Question: Based on the figure, does the quantity rise or fall?
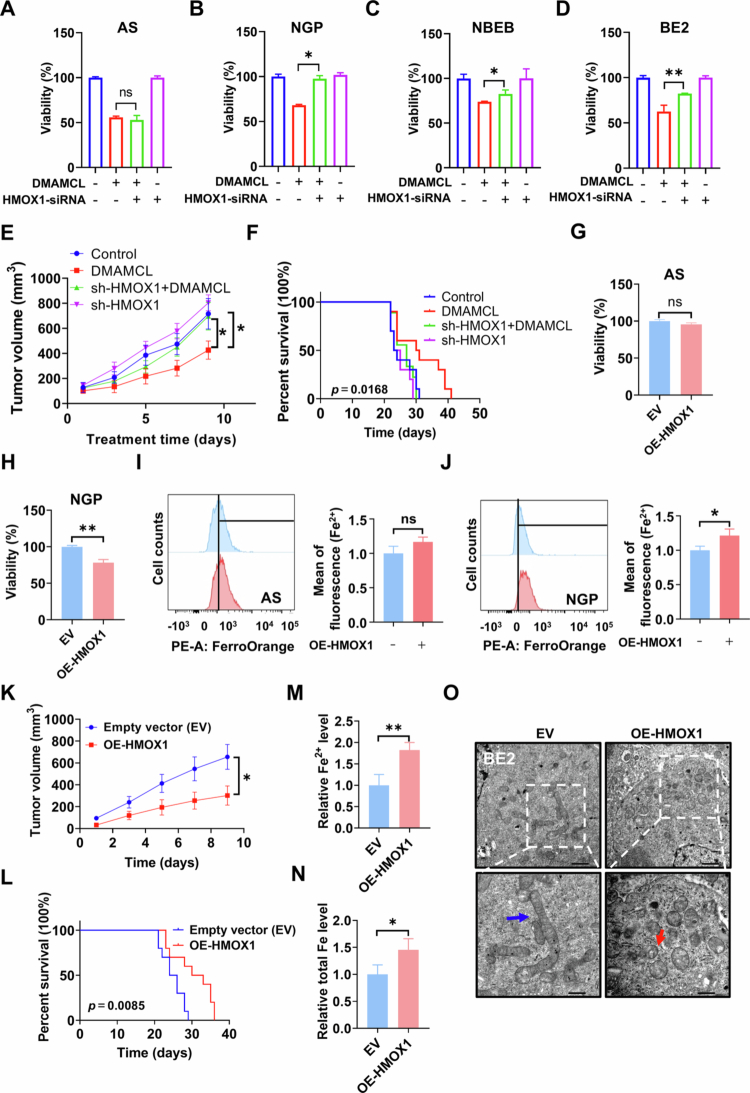
Answer: increasing